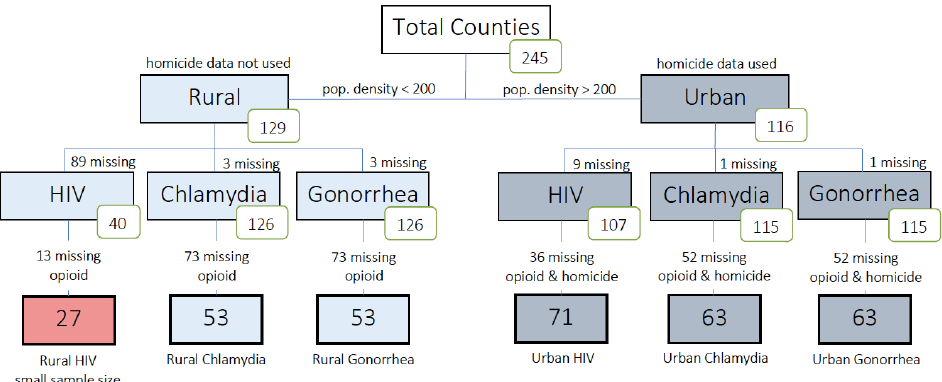
Figure 1. Flowchart showing the inclusion and exclusion criteria to create models of sexually transmitted infections transmitted infections for rural and urban northeast US counties. Counties were first separated for rural and urban northeast US counties. Counties were first separated into rural and urban groups by population density (200 persons per sq. mi.), then further separated by sexually transmitted disease—HIV, Chlamydia, or Gonorrhea. An unrepresentative and sparse dataset led to the exclusion of rural HIV data from the model.